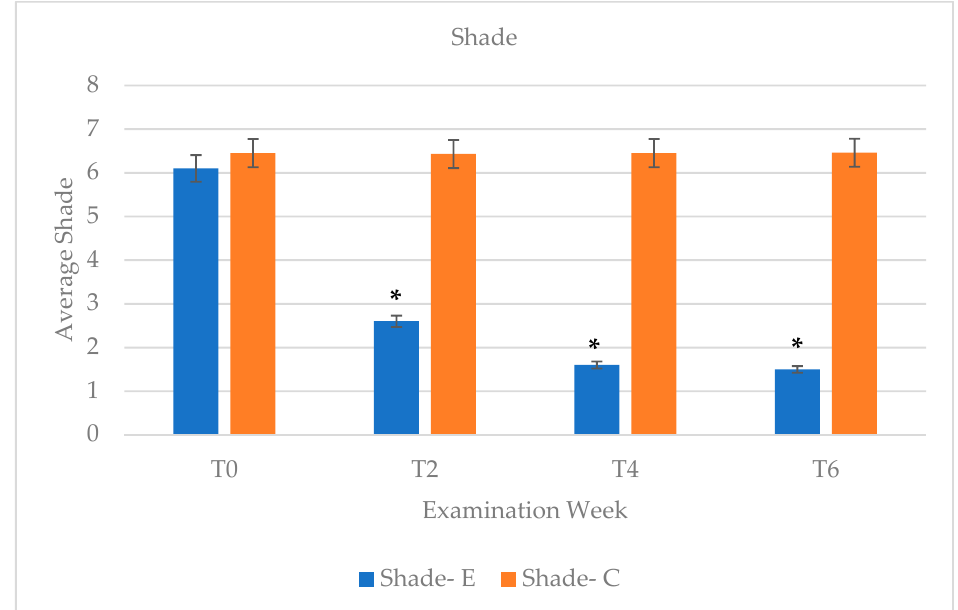
Figure 3. Tooth shade measurements were compared between experimental group (E) and control group (C) and categorized by examination week. Each bar represents an average shade score of each group at each evaluation week. This range of shade measurements received a κ of 0.788 and an inter-exchanger agreement of 87%. (T0—baseline/week 0; T1—week 1; T2—week 2; T4—week 4; T6—week 6) (* p < 0.05).